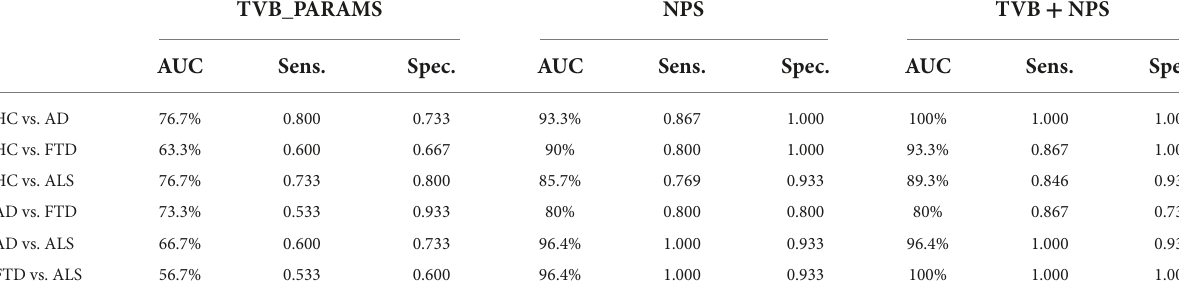
TABLE 4 Classification results (AUC, sensitivity and specificity) for group